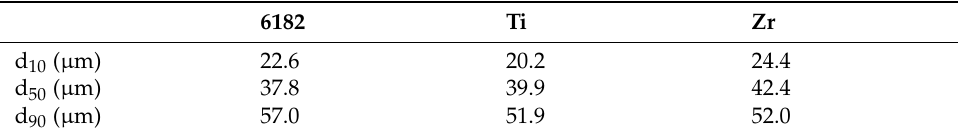
Table 2. PSD of the processed powders.